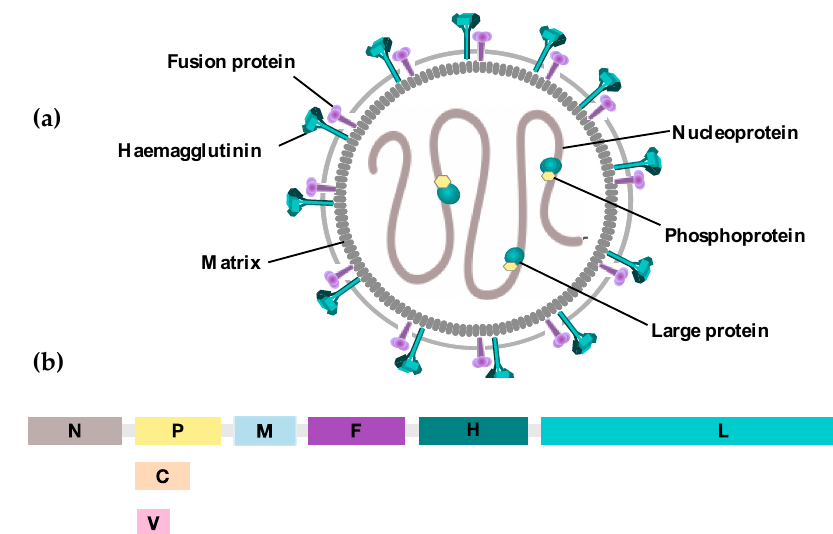
Figure 1. Schematic representation of ( a ) measles virus. Measles virus is an enveloped negative strand RNA virus. The RNA genome is protected by nucleoproteins (N) which are associated with a RNA dependent RNA polymerase (RdRp), known as Large Protein (L), and its cofactor Phosphoprotein (P). Together these comprise the ribonucleoprotein complex (RNP) that is surrounded by the matrix (M). The two viral glycoproteins, Haemagglutinin (H) protein and the Fusion (F) protein, project from the lipid bilayer and are involved in viral entry to the host cell; ( b ) Measles virus genome. The MV genome consists of 15,894 RNA nucleotides comprising six transcription units each separated by trinuclear intergenic sequences. A transcriptional gradient is generated whereby mRNAs are generated with decreasing abundance from the 3 ′ N to the 5 ′ L position. The proteins V and C are non ‐ structural proteins that are generated from an alternative RNA transcript of the P gene.